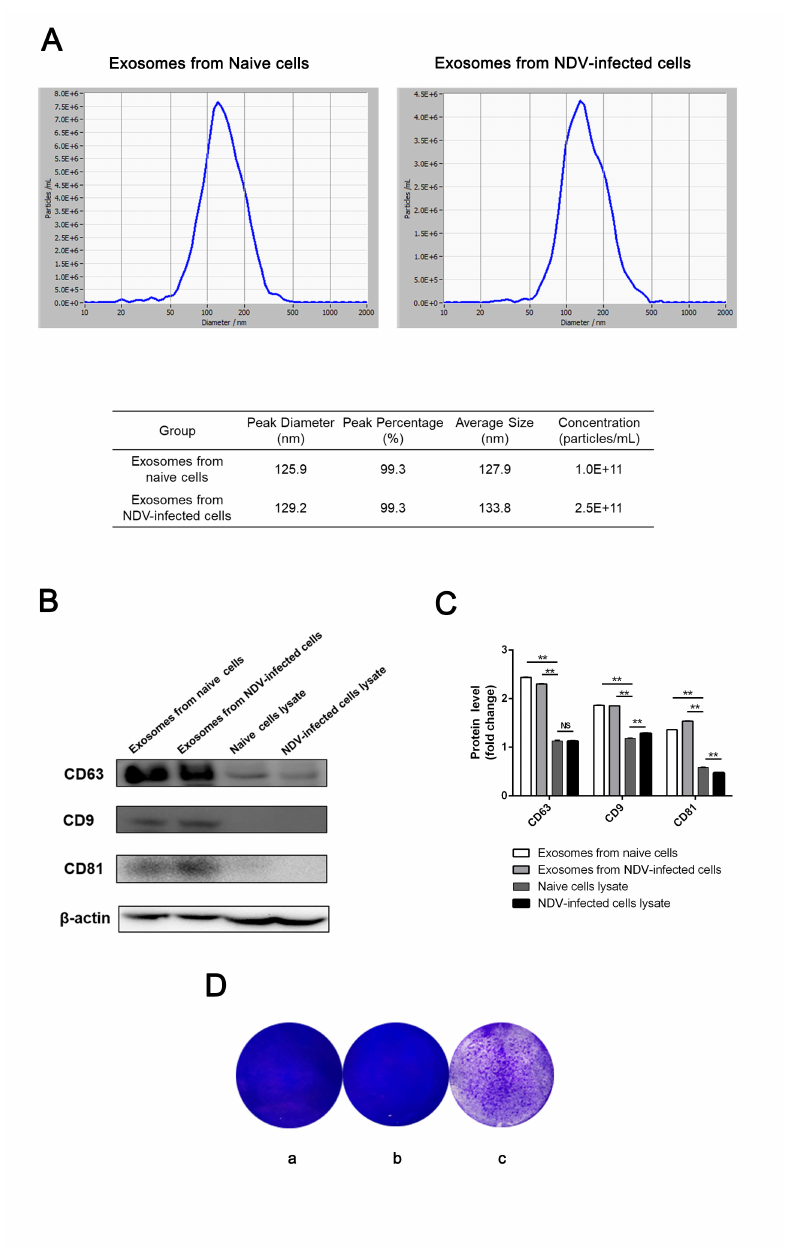
Figure 2. Characterization of exosomes were identified from NDV-infected and naive HeLa cells. ( A ) Size and concentration of exosomes from NDV-infected and naive HeLa cells were measured using nanoparticle tracking analysis. ( B ) CD63, CD9, and CD81 proteins in the exosomes derived from NDV-infected and naive HeLa cells were detected by Western blotting. The expression of these proteins in naive HeLa cell lysates was used as the control. ( C ) Relative expression of the CD63, CD9, and CD81 proteins from (C) was analyzed with Image J software 1.8.0. β -actin was used as an internal control. ( D ). ( a ) Image of plaques formed in HeLa cells infected with NDV alone, ( b ) treated with exosomes derived from naive cells and then infected with NDV, and ( c ) treated with exosomes derived from NDV-infected cells and then infected with